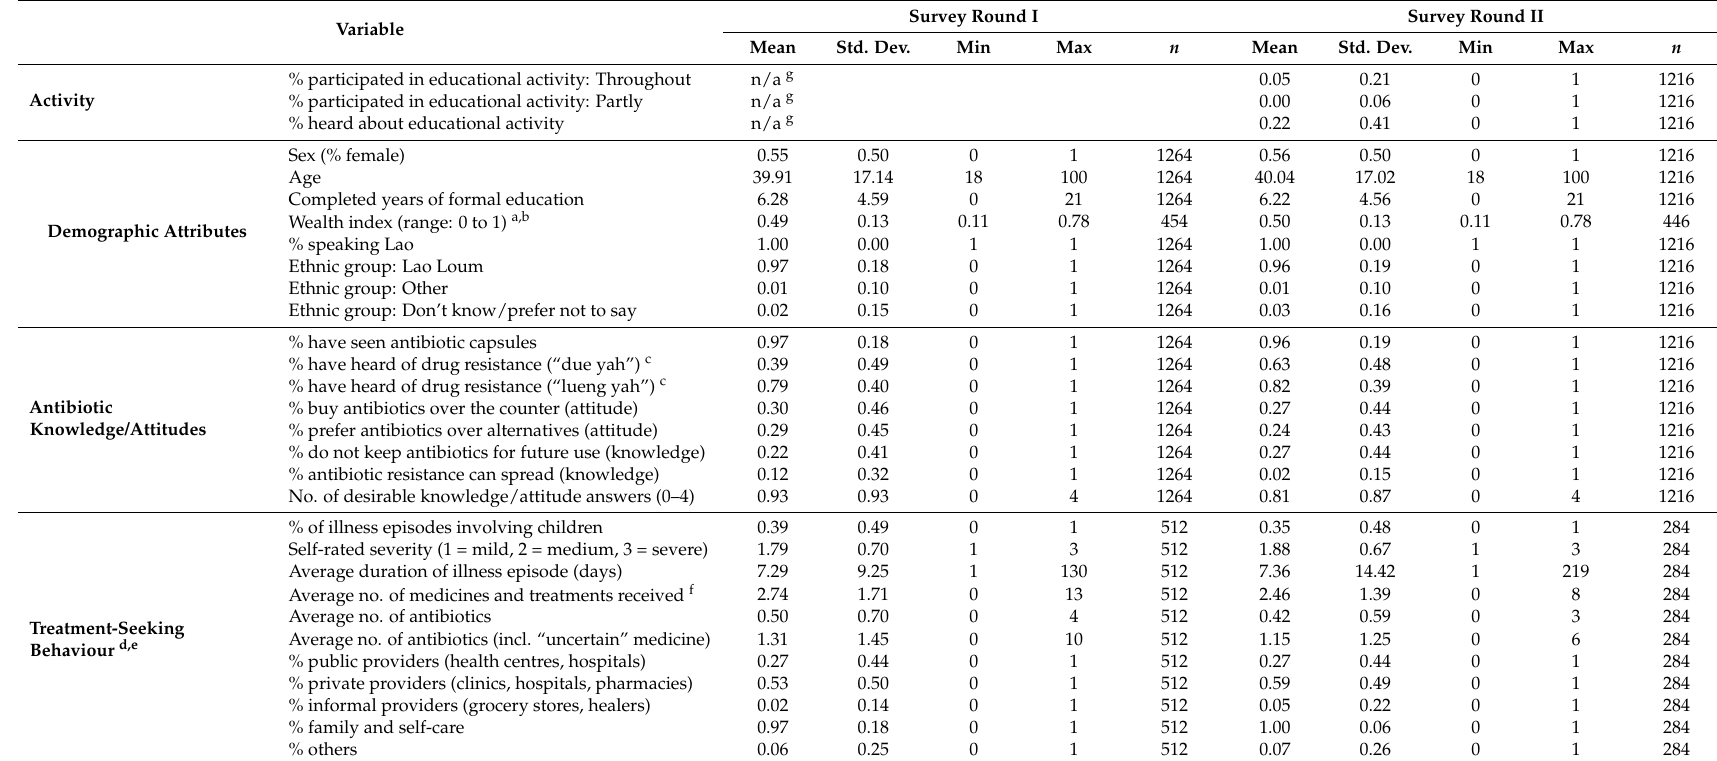
Table 3. Sample characteristics of two rounds of census surveys in two Lao villages. Variable